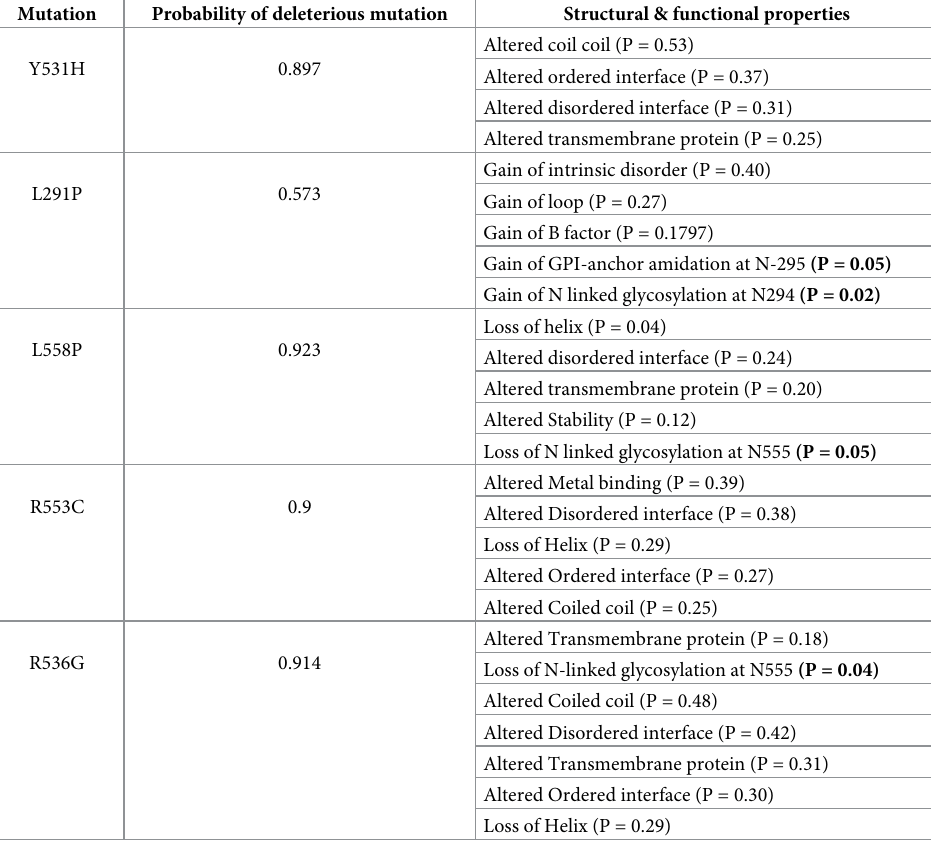
Table 3. Impacts of nsSNPs on structural & functional properties of